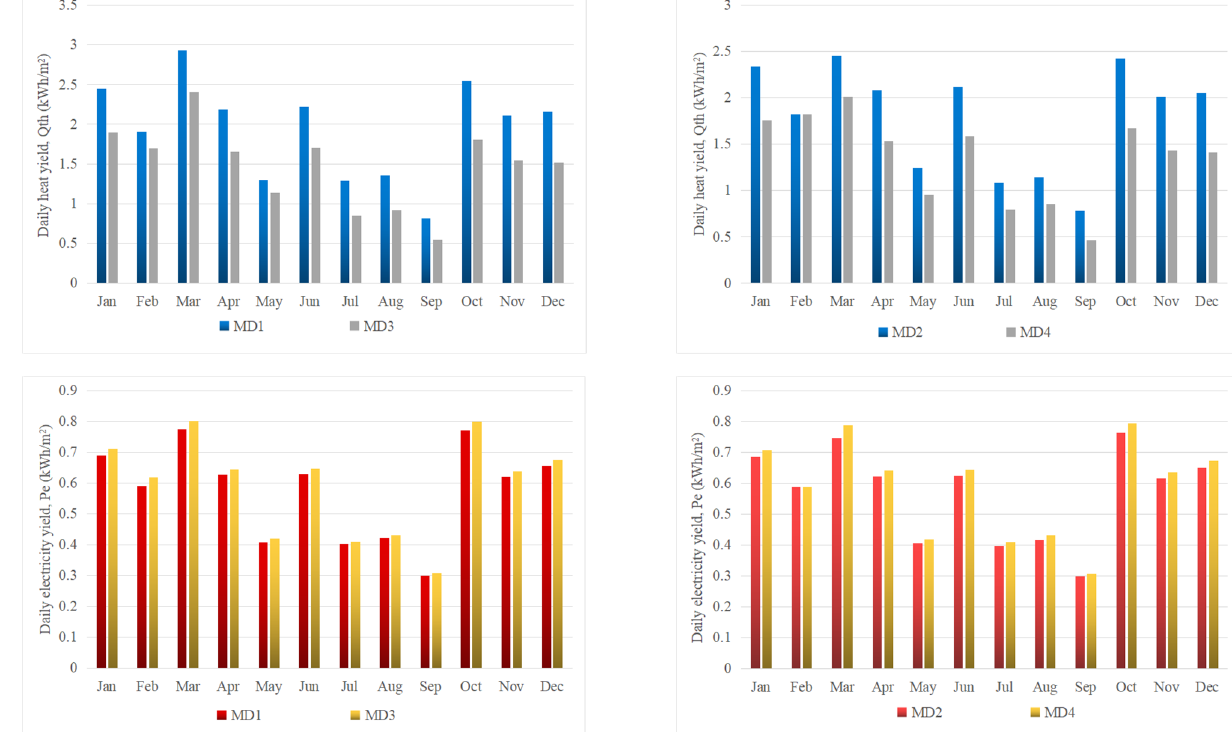
Figure 14. Output of Heat and electricity in typical days of the months.